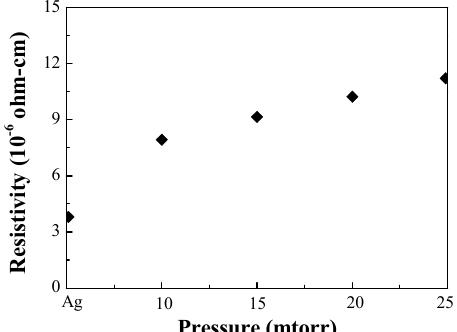
Figure 2. Resistivity of AlTi films prepared at different pressures.